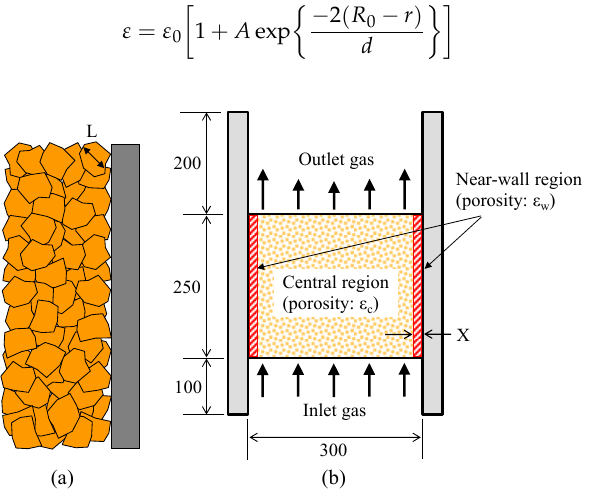
Figure 6. Laboratory-scale CFD simulation model to calculate gas velocity distribution inside and outside chamber: ( a ) schematic image of packing condition around inner wall of chamber; and ( b ) schematic drawing of modeled region.